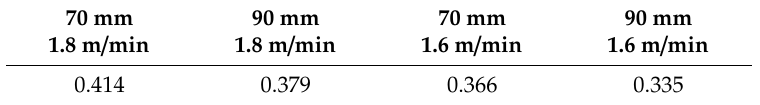
( c ) Figure 8. Slag droplets position at different times: ( a ) t = 5 s; ( b ) t = 10 s; ( c ) t = 15 s.